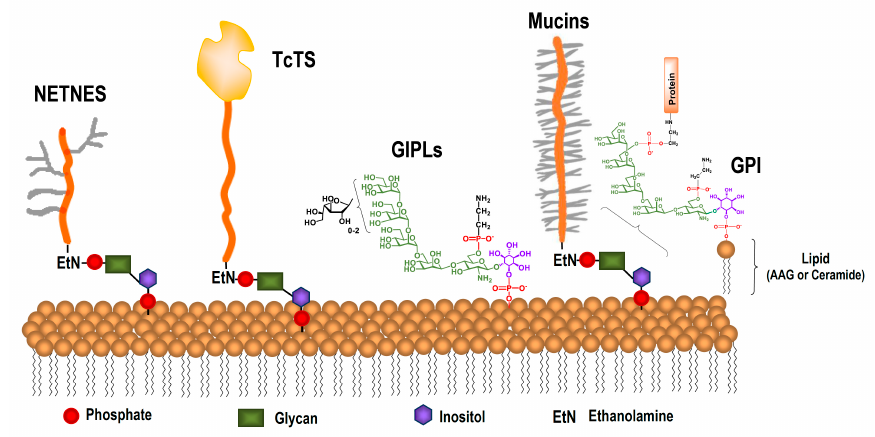
Figure 2. Representative glycoconjugates in the surface of T. cruzi epimastigotes .